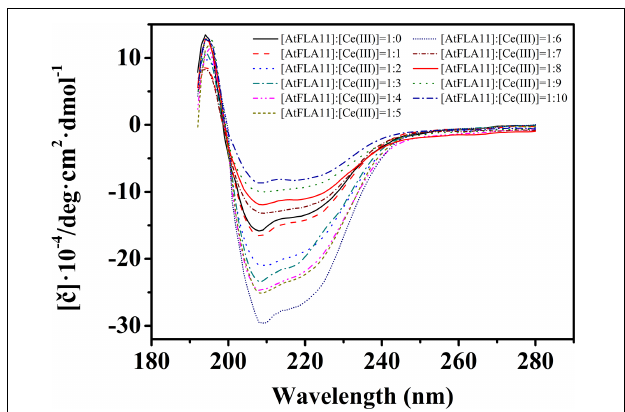
FIGURE 5 | The circular dichroism spectra of 1.00 × 10 − 6 M AtFLA11 incubated with Ce(III) at different concentrations. The measurements were carried out 12 h after incubating AtFLA11 with